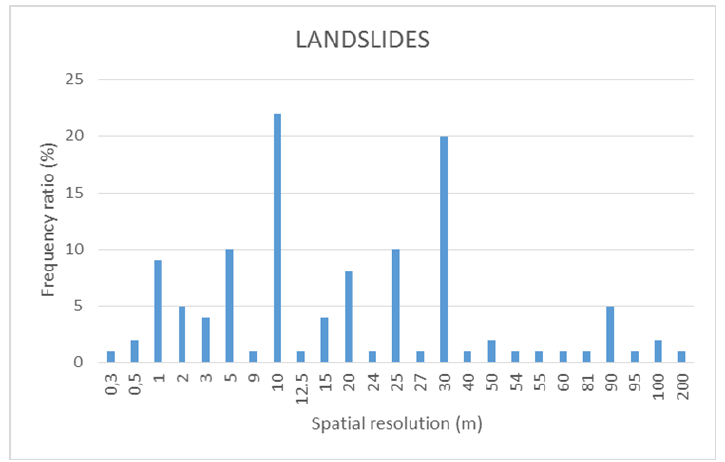
Figure 4. The frequency of spatial resolutions ’ use in landslide investigations.